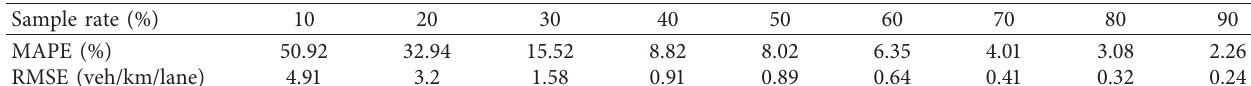
Figure 9: Estimated traffic density by sample rate of scenario 2 (empirical evaluation). (a) Ground truth of traffic density. (b) Estimated density at 10% sample rate. (c) Estimated density at 20% sample rate. (d) Estimated density at 30% sample rate. Table 8: MAPE and RMSE comparison of scenario 2 (empirical evaluation).